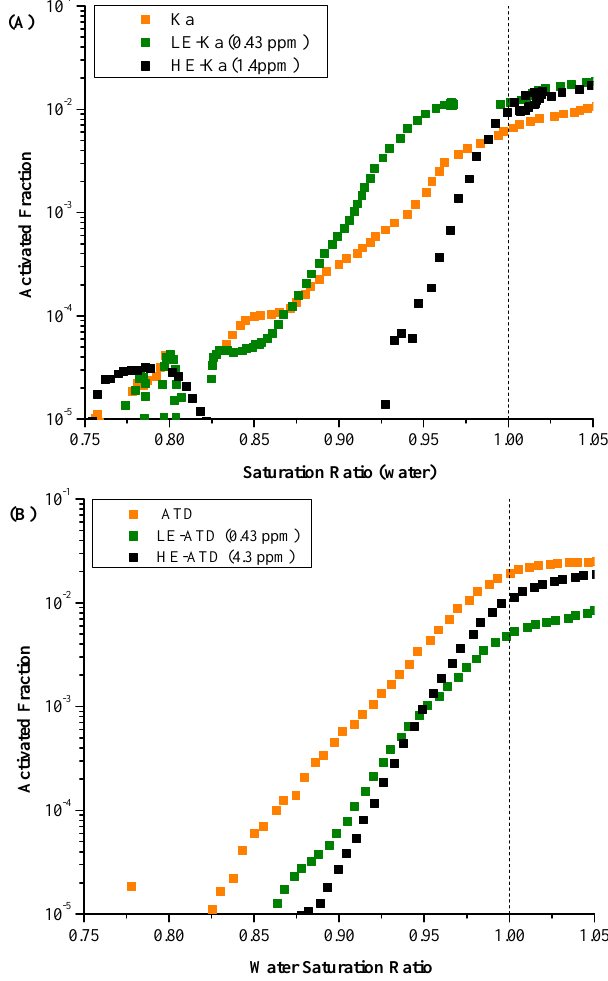
Fig. 6. Relative humidity scans for Ka (A) and ATD (B) particles performed in PINC for nominal temperature of 236K. The gap in data for LE-Ka is data missing due to fictitious inflated counts from frost falling off the chamber walls being sampled by the OPC. Dashed line: water